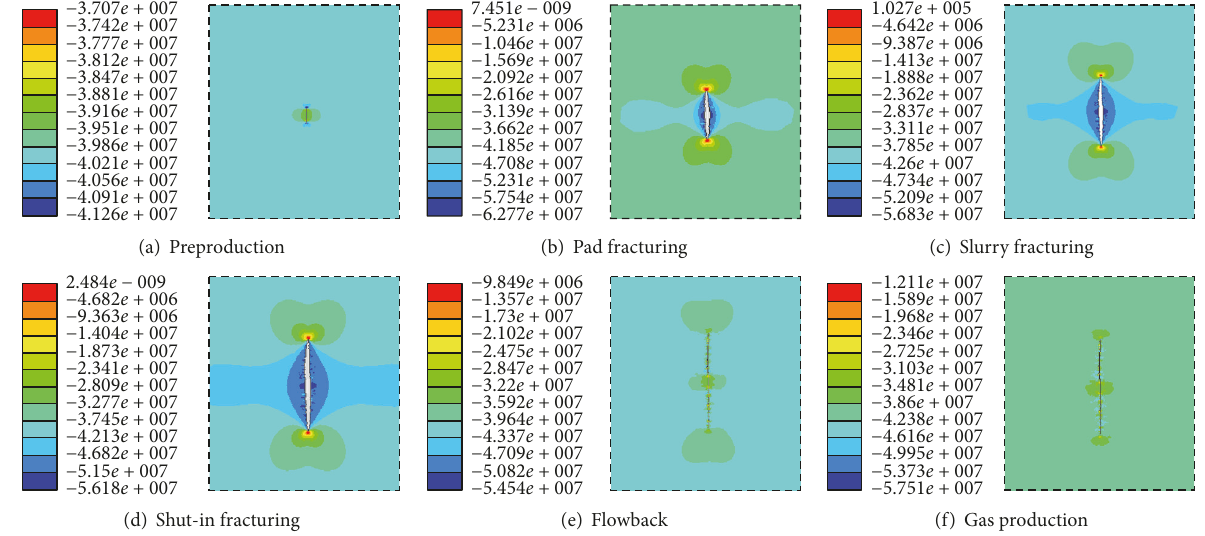
Figure 5: Dynamic propagation of cracks and first principal stress (Pa) in preproduction, fracturing, flowback, and gas production stages in unfractured reservoir.